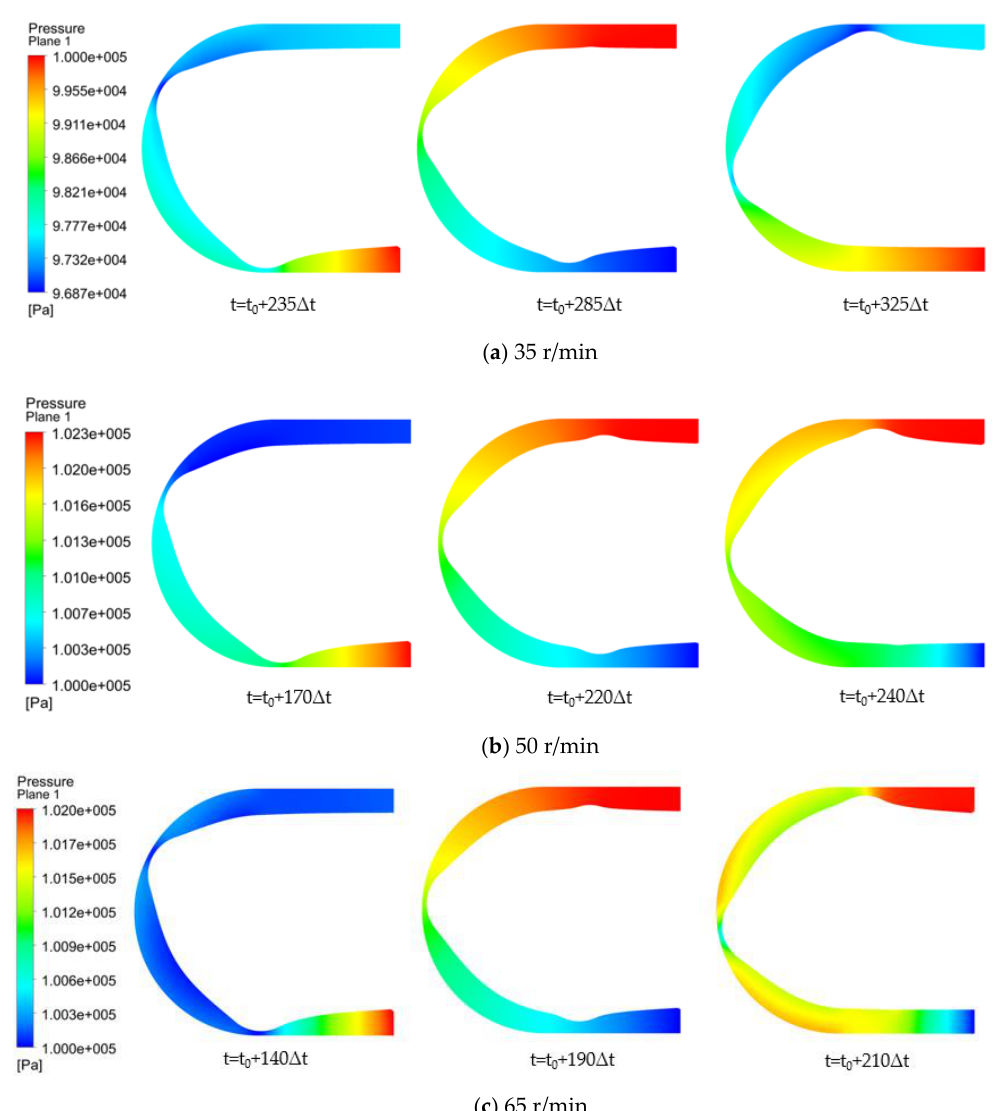
Figure 10. Static pressure distribution of the 0.1 MPa outlet pressure at different speeds.